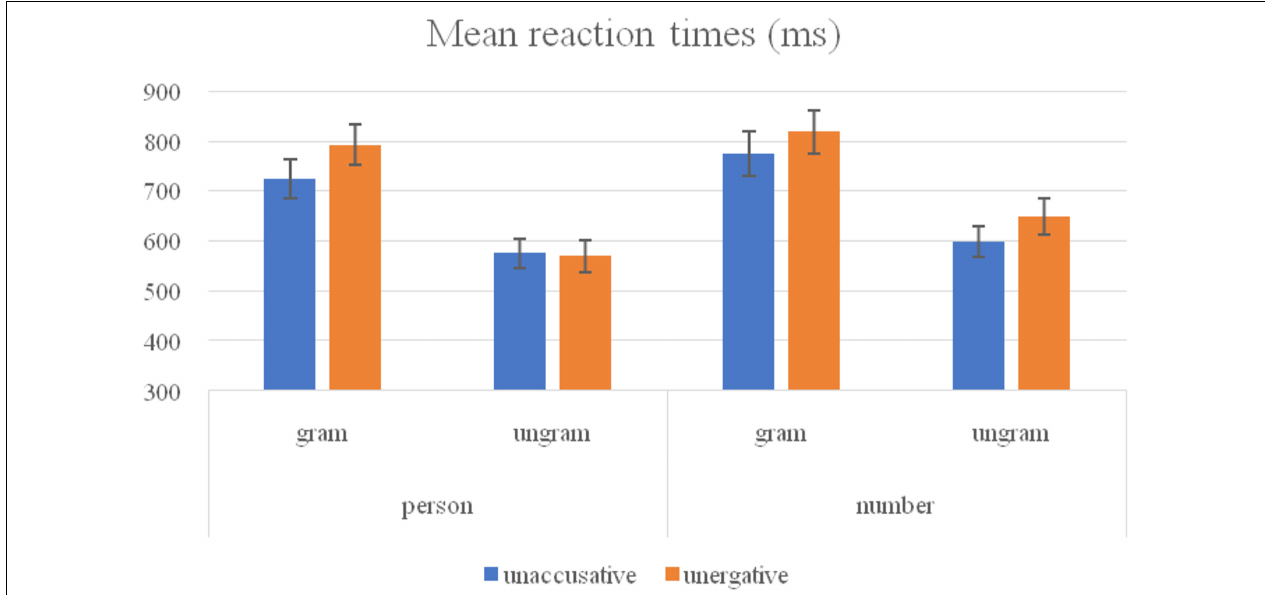
FIGURE 2 | Mean reaction times (ms) and standard deviation error (SDE) of non-native speakers of